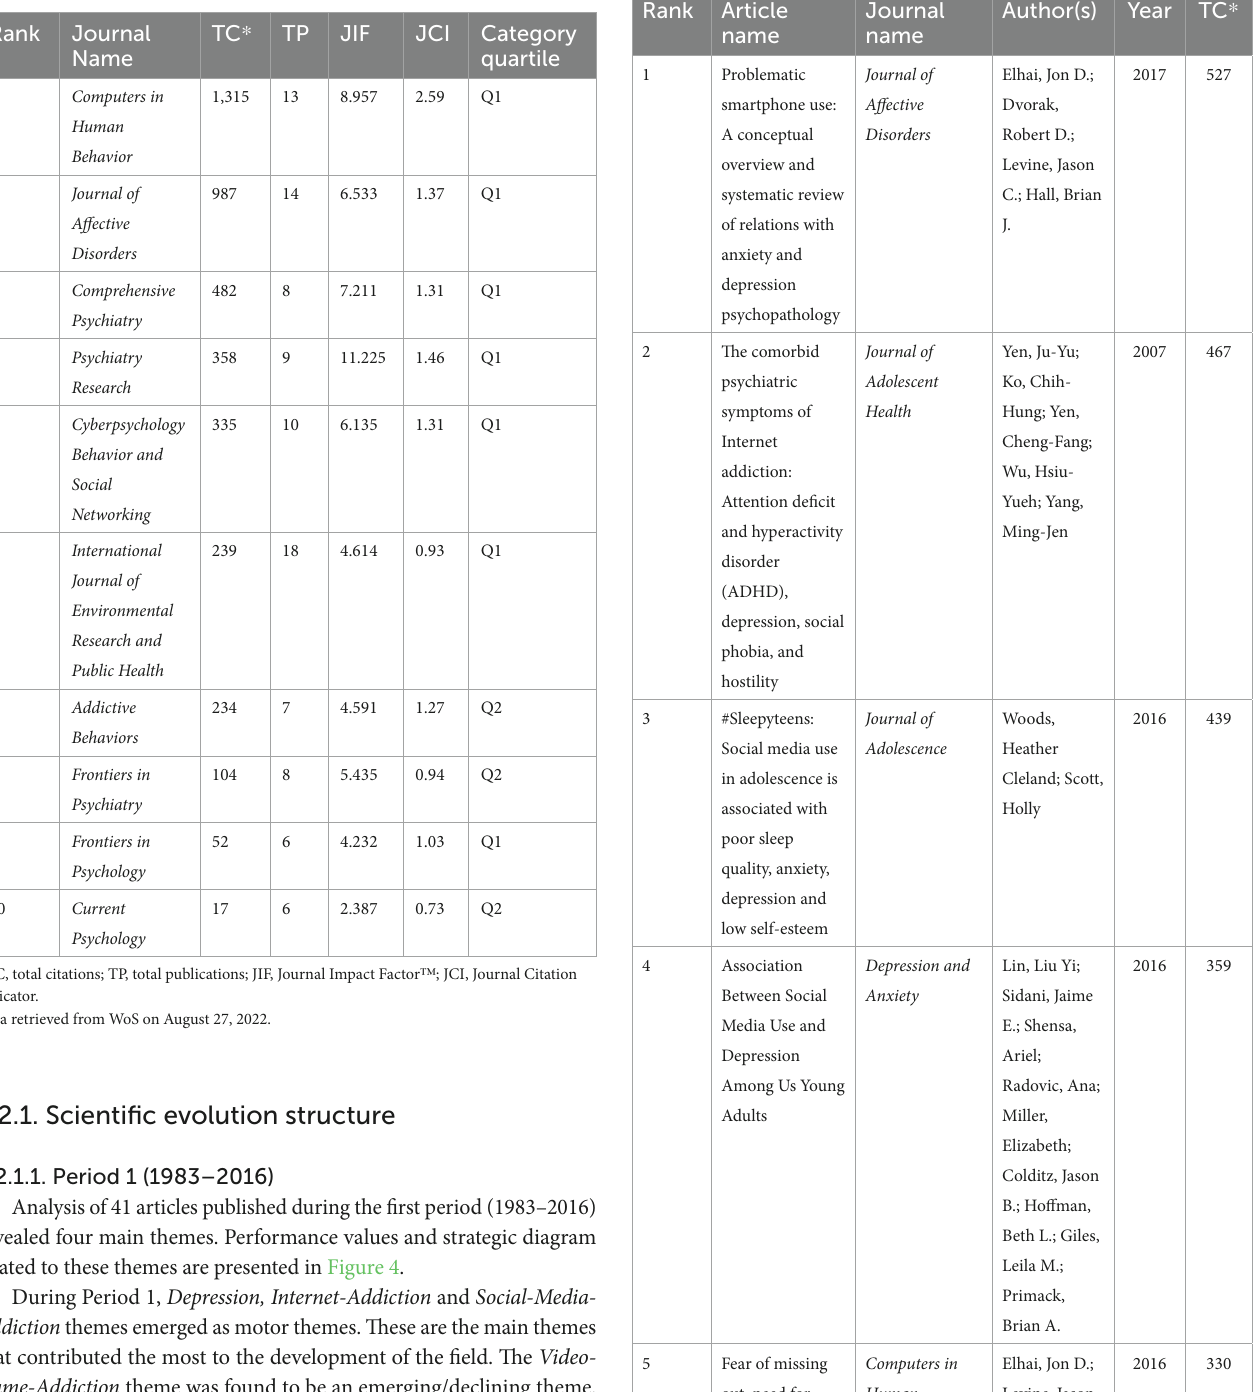
TABLE 3 Top 10 journals most cited in the digital addiction–depression domain.